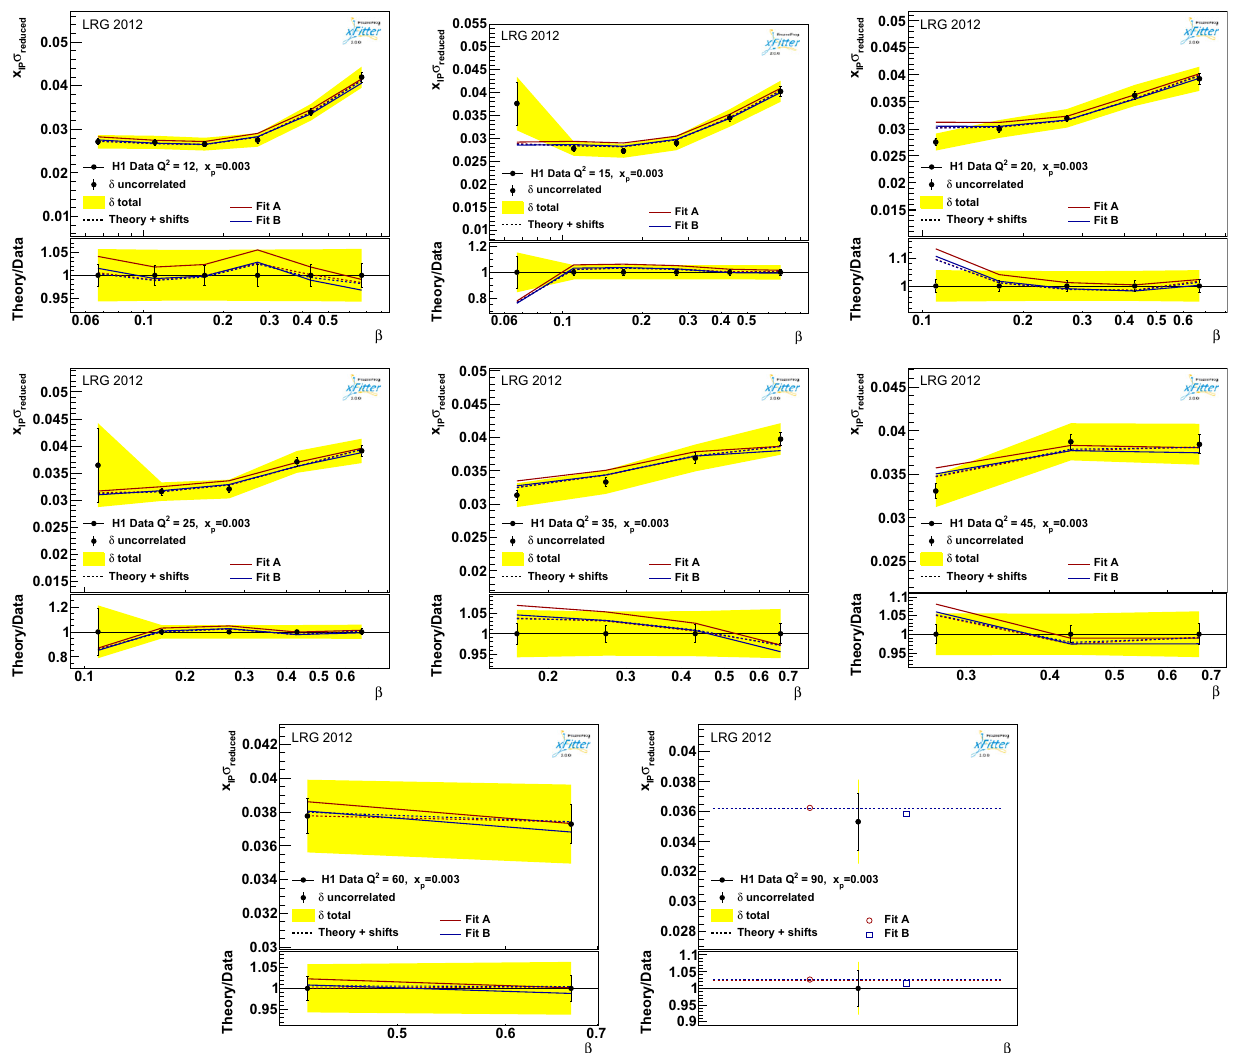
( 3 ) β for x = 0 . 003 in IP r as a function of